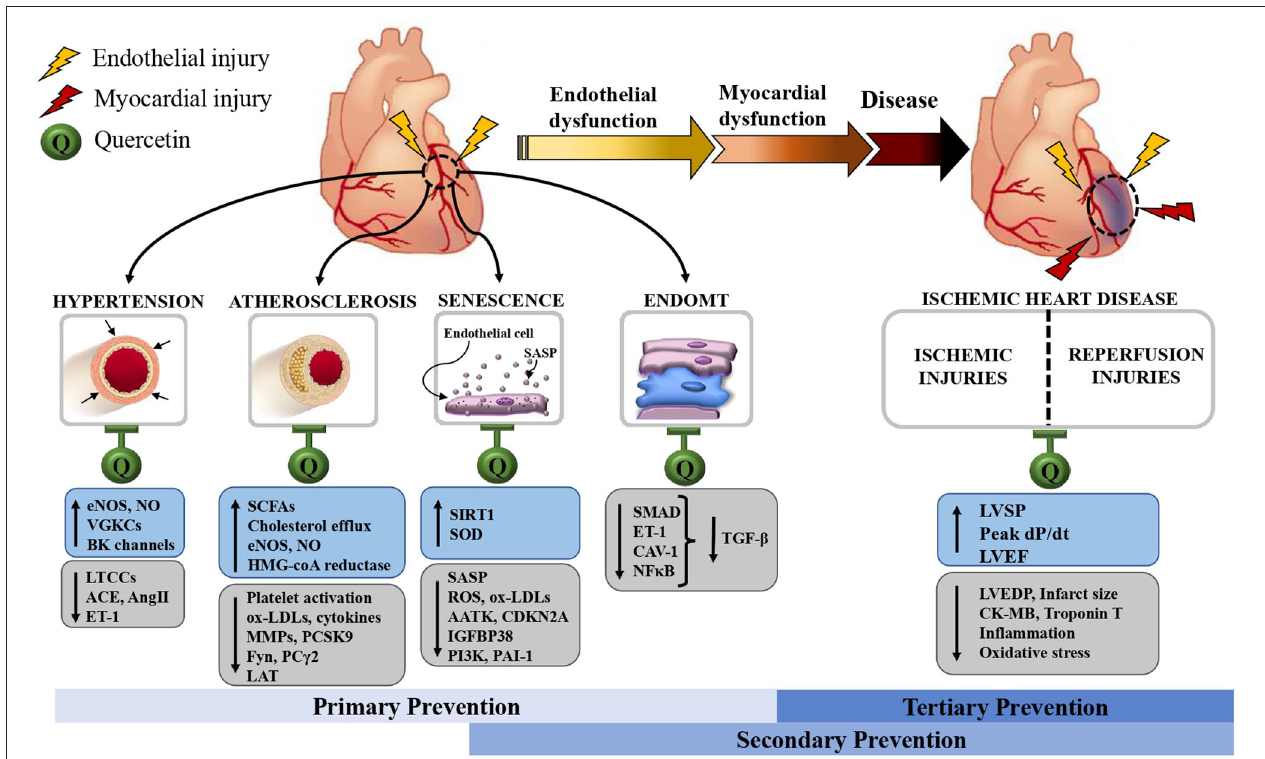
FIGURE 5 | Schematic representation of the endothelial and, by extension, myocardial protective effects of quercetin. These allow quercetin to act as a primary, secondary and tertiary preventive measure against cardiovascular diseases. AATK: apoptosis-associated tyrosine kinase; ACE: angiotensin-converting enzyme; AngII, angiotensin II; BK, big K, large-conductance Ca 2 + -sensitive K + channels; CAV-1, caveolin-1; CDKN2A, p16, cyclin-dependent kinase inhibitor 2A; CK-MB, creatinine kinase-MB; EndoMT, endothelial-to-mesenchymal transition; ET-1, endothelin-1; IGFBP3, insulin-like growth factor binding protein-3; eNOS, endothelial nitric oxide synthase; NF κ B, nuclear factor-kappa B; NO, nitric oxide; ox-LDLs, oxidized low density lipoproteins; Fyn, Src family 59 kDa non-receptor protein tyrosine-kinase; LAT, linker for activation of T cells; LTCCs, L-type Ca 2 + channels; LVEDP, left ventricular end-diastolic pressure; LVEF, left ventricular ejection fraction; LVSP, left ventricular systolic pressure; MMPs, matrix metalloproteases; PAI-1, plasminogen-activated inhibitor-1; PCSK9, proprotein convertase subtilisin/kexin type 9; PI 3 K, phosphatidylinositol-4,5-bisphosphate 3 kinase; PLC γ 2, phospholipase C γ 2; SCFAs, short-chain fatty acids; ROS, reactive oxygen species; SASP, senescence-associated secretory phenotype; SIRT1, sirtuin-1, nicotinamide adenine dinucleotide [NAD( + )]-dependent protein deacetylase; SOD, superoxide dismutase; TGF- β , transforming growth factor beta; VGKCs, voltage-gated K +